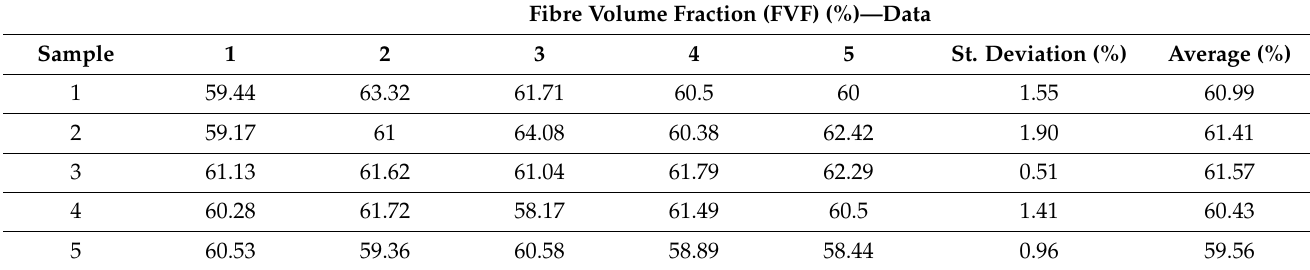
Table A3. Compression test porosity results of the first five specimens, compressed at 210 °C and 10 min of dwell time, with various compaction pressures (sample 1 with 10 MPa, 2 with 8 MPa, 3 with 6 MPa, 4 with 4 MPA, 5 with 2 MPa).